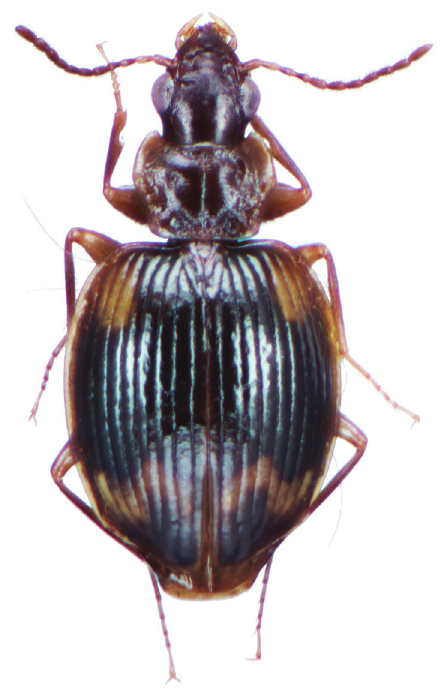
Figure 13. Dorsal habitus and color pattern of Bellavalentis kuzugamii (Shibata). (OBL 3.26 mm). proepipleuron, mesepisternum, and metepisternum with sculpticells forming a shal- low transverse